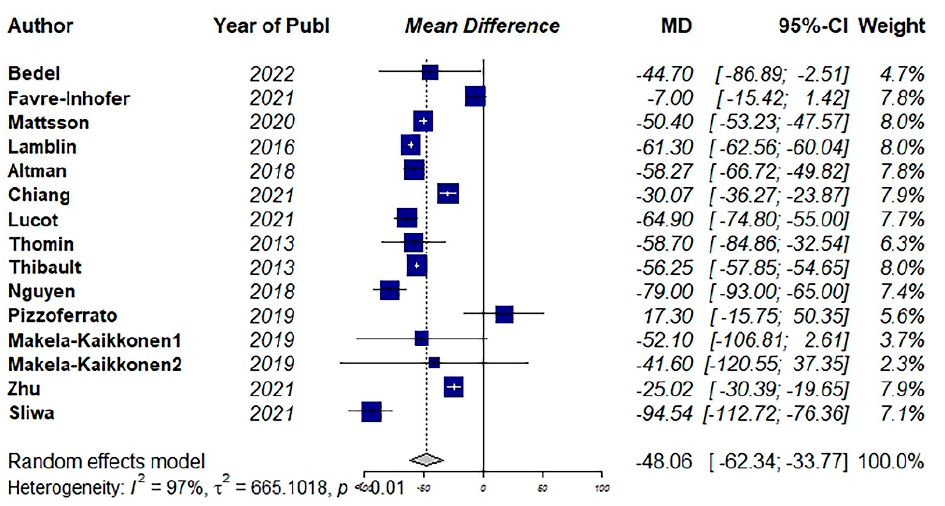
Figure 3. Pooled mean difference of the effect of surgical intervention (vaginal and abdominal sur- gery) on total quality of life score using the Pelvic Floor Distress Inventory Questionnaire (PFDI) [31,33,36,37,40–42,45,47,51,52,55,56].